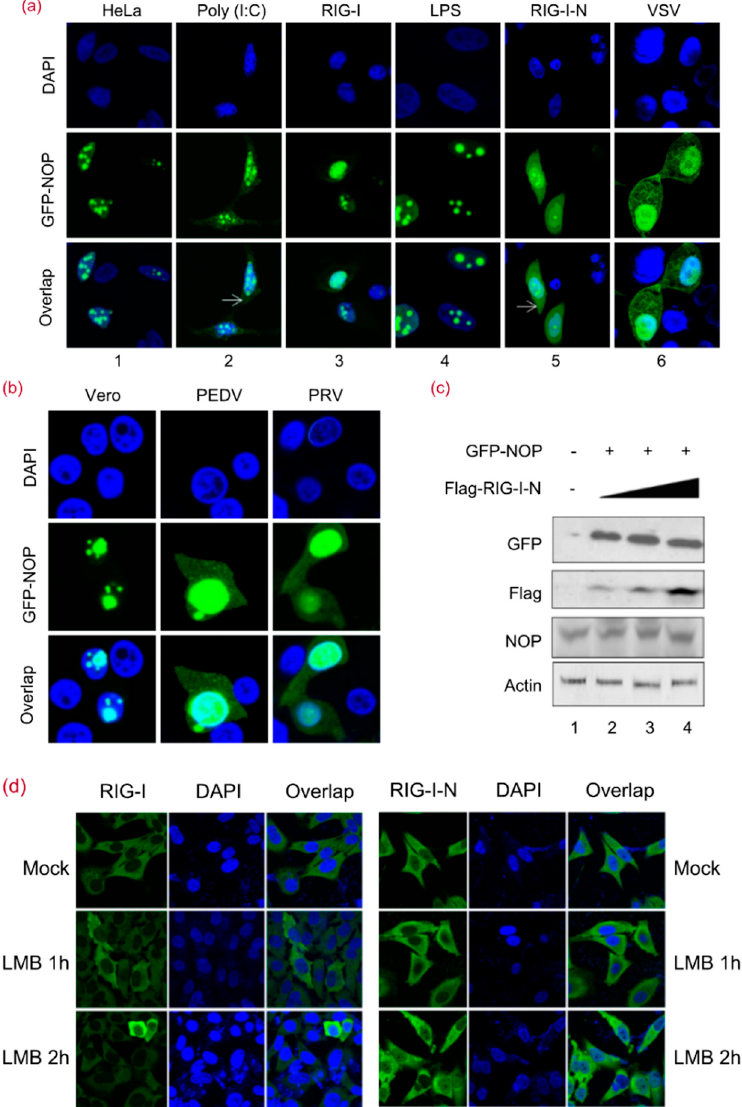
Figure 2. RIG-I-N or Poly (I:C) Stimulation Directly Induces NOP53 Migration. ( a ) HeLa cells in 24-well plate were transfected with plasmids encoding GFP-tagged NOP53, along with poly (I:C), RIG-I, or RIG-I-N (500 ng each) for 24 h or treated with LPS at 100 ng/mL (lanes 1–5). HeLa cells were transfected with plasmids for expressing GFP-tagged NOP53 for 24 h and infected with VSV at an MOI of 5 for 10 h (lane 6). The cells were fixed with 4% paraformaldehyde. Nuclei were stained with DAPI, and NOP was visualized from the fused GFP fluorescence. Images were captured using 100 × objectives with an Olympus FluoView™ FV1000; ( b ) Vero cells were transfected with plasmids encoding GFP-tagged NOP53 for 24 h and mock-infected or infected with PEDV or PRV at 10 MOI for 10 h. The cells were fixed with 4% paraformaldehyde. Nuclei were stained with DAPI, and NOP was visualized from the fused GFP fluorescence. Images were captured using 100 × objectives with an Olympus FluoView™ FV1000; ( c ) HEK293T cells were co-transfected with GFP-tagged NOP53 expression plasmid and increasing doses of plasmids encoding Flag-tagged RIG-I-N. Protein levels of transfected (GFP) and endogenous (NOP) NOP53 were analyzed by immunoblotting with the indicated antibodies; ( d ) HeLa cells grown in 24-well plates and transfected with plasmids encoding GFP-tagged RIG-I or RIG-I-N (500 ng each) were treated with 1 µM LMB for 1 or 2 h. The cells were fixed with 4% paraformaldehyde. Nuclei were stained with 4 ′ ,6-diamidino-2-phenylindole (DAPI), and RIG-I or RIG-I-N was visualized from the fused GFP fluorescence. Images were captured using 40 × objectives with an Olympus FluoView™ FV1000.